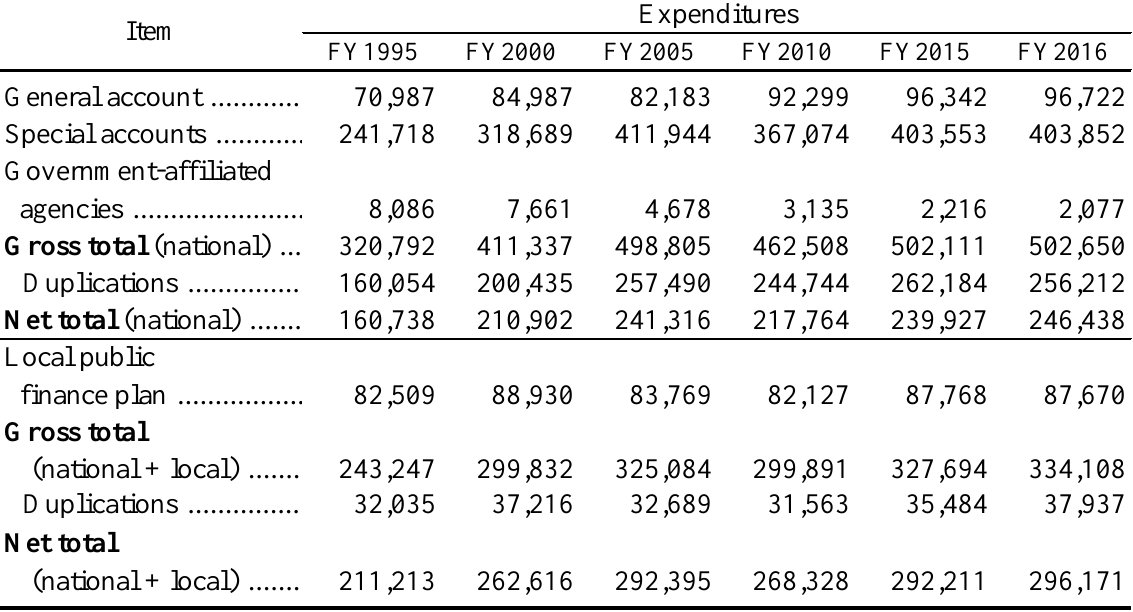
Expenditures of National and Local Governments (Initial